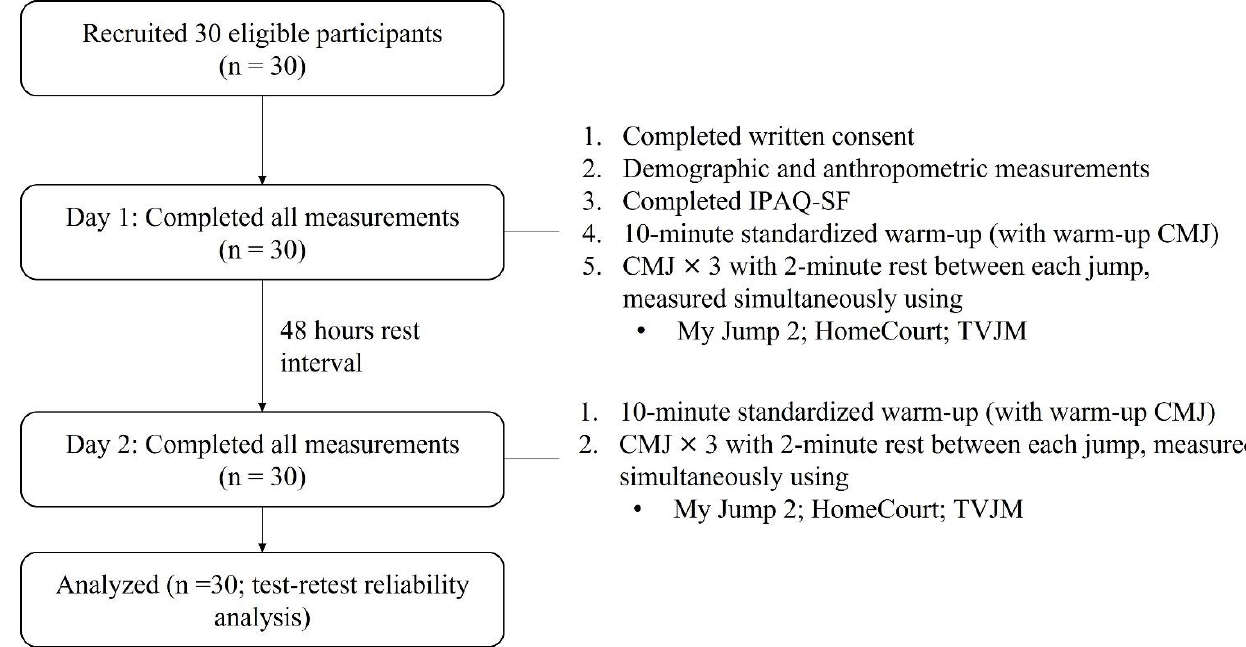
Figure 1. Study flow chart. Abbreviations: CMJ: Countermovement jump; TVJM: Takei Vertical Jump Meter.